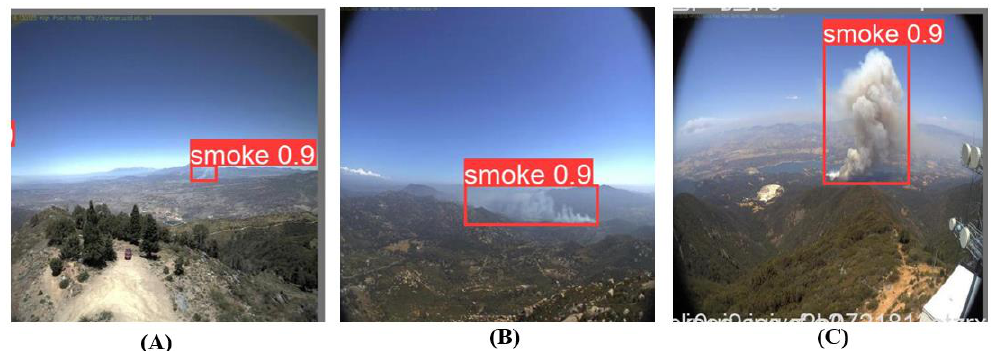
Figure 11. YOLOv3 detection areas results. ( A ) Far. ( B ) Medium. ( C ) Close.